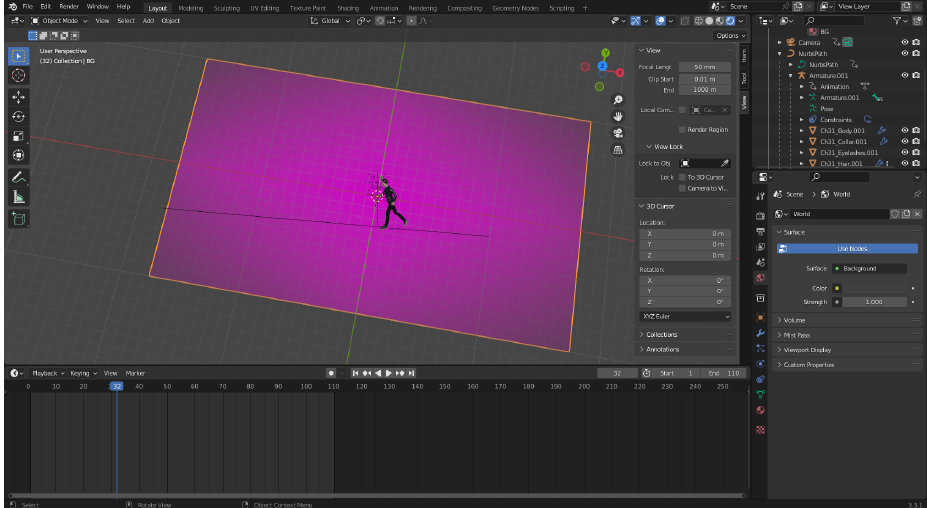
Figure 5. Manual creation of image and video data via 3D modelling software such as